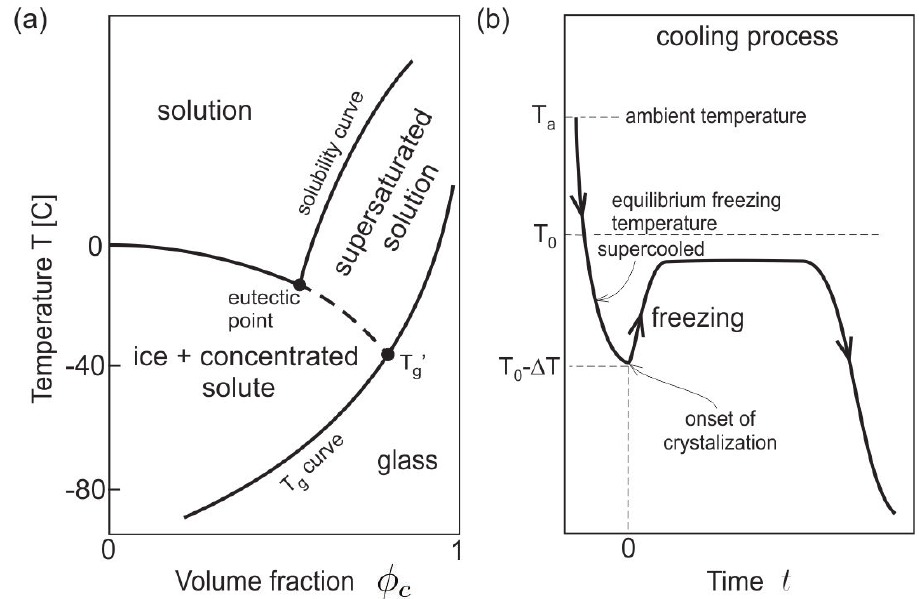
Figure 1. ( a ) Temperature–composition phase diagram of a binary protein solution including freezing, solubility, glass transition curves, and material states. ( b ) Schematic of the cooling process in terms of the average temperature of the representative volume versus time, and with initial condition defined at the crystallization point with temperature T 0 − ∆ T , where the subcooled temperature ∆ T is used for temperature